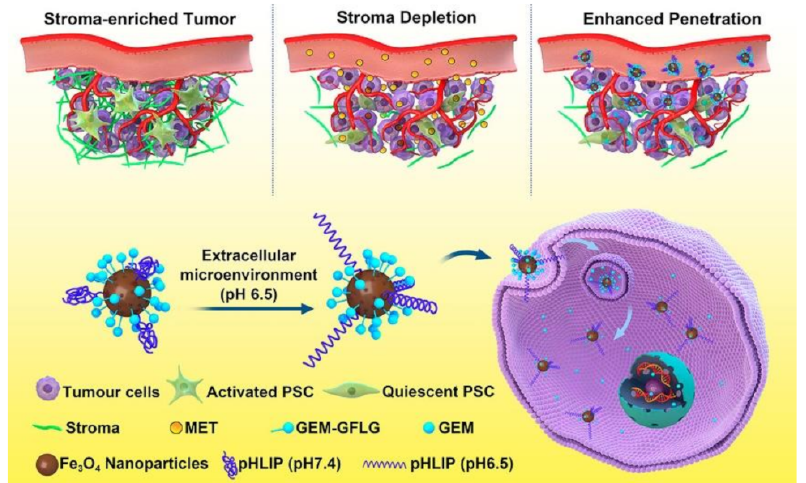
Figure 8. Schematic representation of MET-induced stromal depletion for enhancing the penetration and cathepsin B-triggered release of GEM carried by Fe 3 O 4 NPs in the lysosome of pancreatic ductal adenocarcinoma (PADC) cells. The pHLIP facilitates the internalization of the underlying Fe 3 O 4 NPs by inserting into cell membranes because it can format stable transmembrane α -helix in acidic tumor microenvironment. Once internalized into the cancer cells, GEM will be released in lysosome upon cleavage of its linker (i.e., GFLG peptide) by cathepsin B. In the animal experiments, MET was intraperitoneally injected to deplete the dense stromal barrier of PDAC prior to the injection of the above nanoagents to facilitate the effective delivery of GEM. (Adapted from Han et al. 2020 [205], Copyright 2020 American Chemical Society and reproduced with